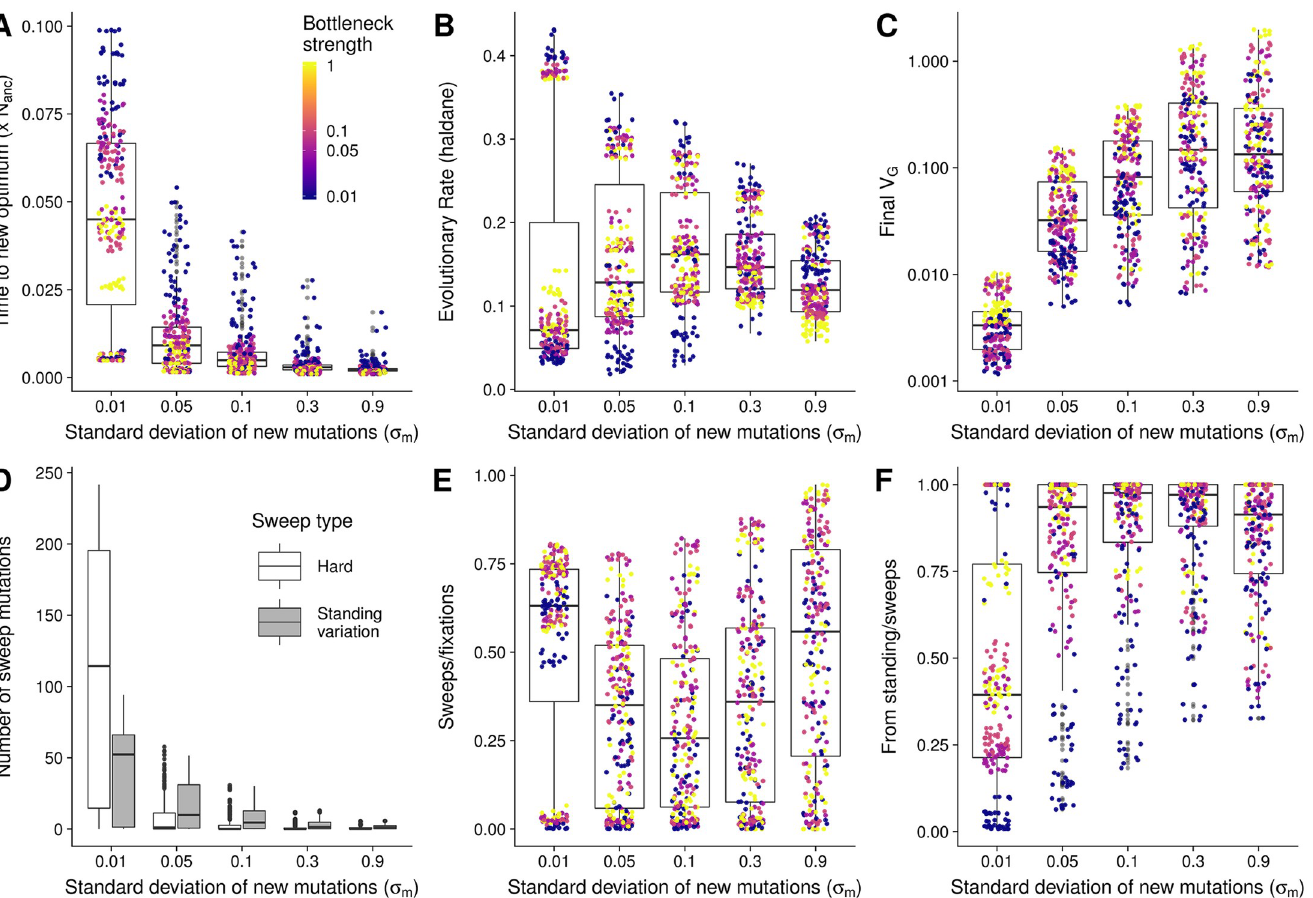
Fig 4. Summary of trait adaptation and selective sweeps. A ) Time to reach new trait optimum B ) Rate of change in phenotype C ) Genetic variance after 0.1 × N anc generations. D ) Total number of selective sweeps, separated by type of sweeps. E ) Proportion of sweeps compared to all fixations F ) Proportion of sweeps from standing variation. Boxes are split by major parameter importance as identified by our random forest model. Points in A-C and E-F show the values of each of 1,200 parameter sets and are colored according to bottleneck size (Darker color indicate stronger bottleneck, see legend in A). Interactive plots are available at https://